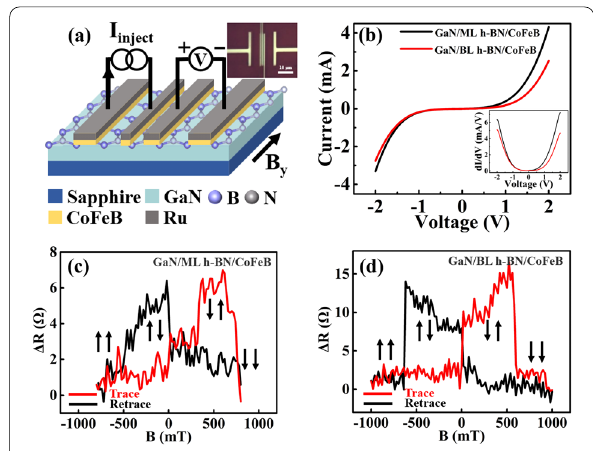
Fig. 3 ( a ) Schematic and optical image (inset) of the four-terminal spin valve devices; ( b ) Two-terminal I–V test at RT, where the black and red lines represent the devices with monolayer and bilayer h-BN (denoted as BL h-BN in the figure) as the tunnelling barriers, respectively; ( c , d ) ΔR as a function of in-plane magnetic field for the devices with monolayer and bilayer h-BN as the tunnelling barriers at RT,